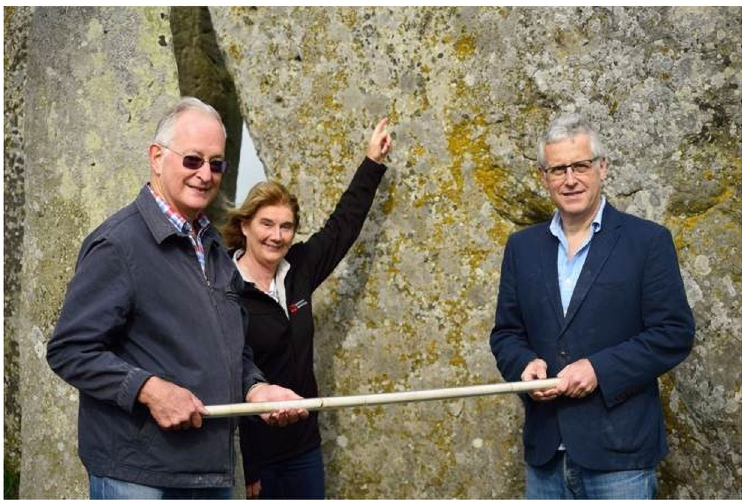
Fig 4. Lewis (left) and Robin Phillips (right) at Stonehenge, handing over the ‘Phillips’ Core’ from Stone 58 to Senior Property Curator, Stonehenge, Heather Sebire (pictured pointing at the position from which the core was drilled. Permission was obtained from the individuals pictured to appear in this image and to be identified by name. This image is reproduced under a CC BY 4.0 license, with permission from English Heritage, original copyright